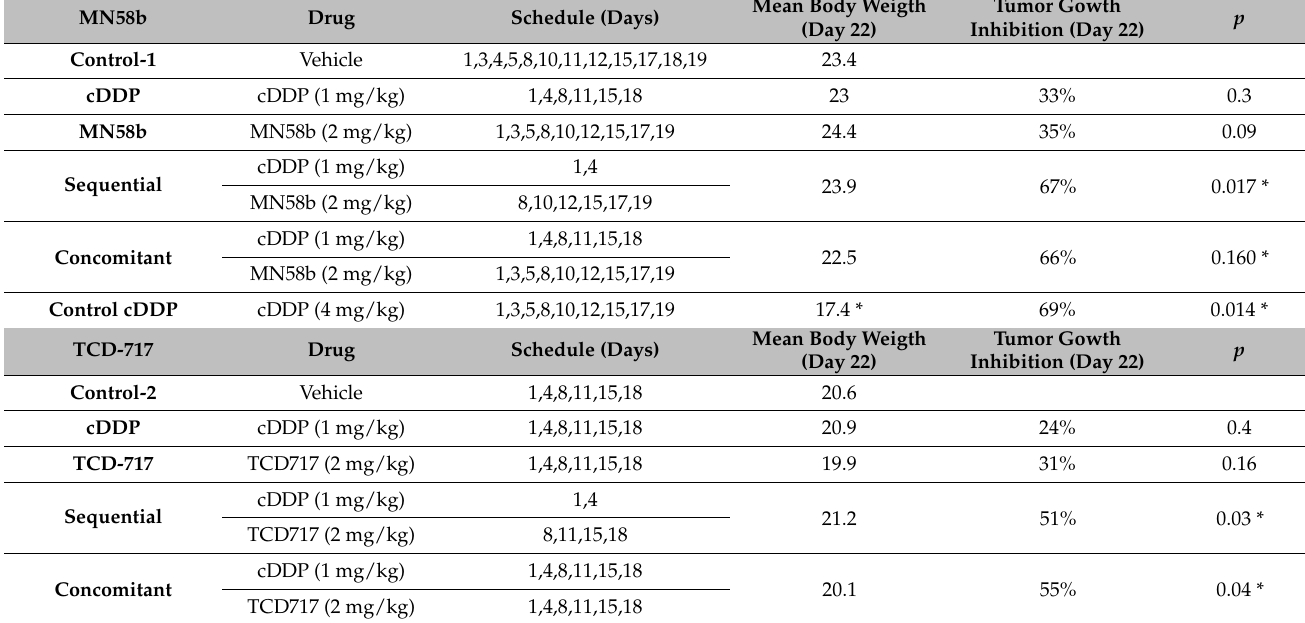
Table 3. Synergistic antitumoral effect of cisplatin and ChoK α inhibitors in vivo. The antitumoral effect of the combination of cisplatin and MN58b or RSM932A/TCD-717 was evaluated in vivo using NSCLC xenografts. H460 cells were injected in nude mice, and when tumor volumes reached 0.1 cm 3 , animals were randomly distributed in groups ( n = 8) to start treatments according to the schedules described in Material and Methods (indicated as the days treatment was performed for each drug or vehicle (DMSO)). Tumor growth inhibition, mean body weight, and statistical significance are shown. More similar efficacy was observed with the combinations than with much higher concentrations of cisplatin alone, significantly reducing toxicity. * statistical significance p <